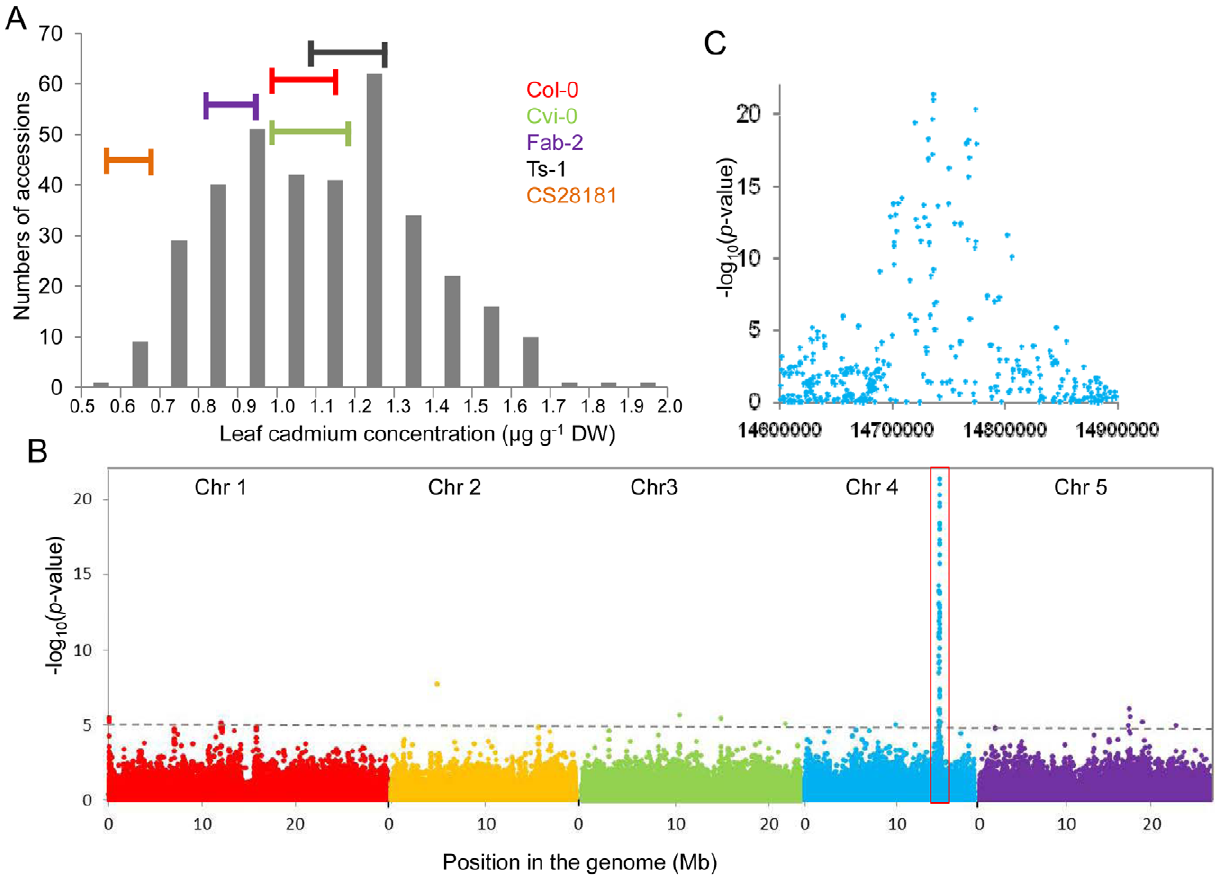
Figure 1. Genome-wide association analysis of leaf Cd accumulation in a worldwide collection of A.thaliana accession grown in a common garden. A. The frequency distribution of leaf Cd concentration in 349 A. thaliana accessions grown in a common garden. Horizontal bars represent the standard deviations of five accessions grown in all experimental blocks. B. Genome-wide association mapping of leaf Cd at 213,497 SNPs across 337 A. thaliana accessions using a mixed model analysis implemented in EMMA [33]. Horizontal dashed line indicates a genome-wide significance threshold of 2 log 10 =5. C. Detailed plot of the region shown in the red box in B.